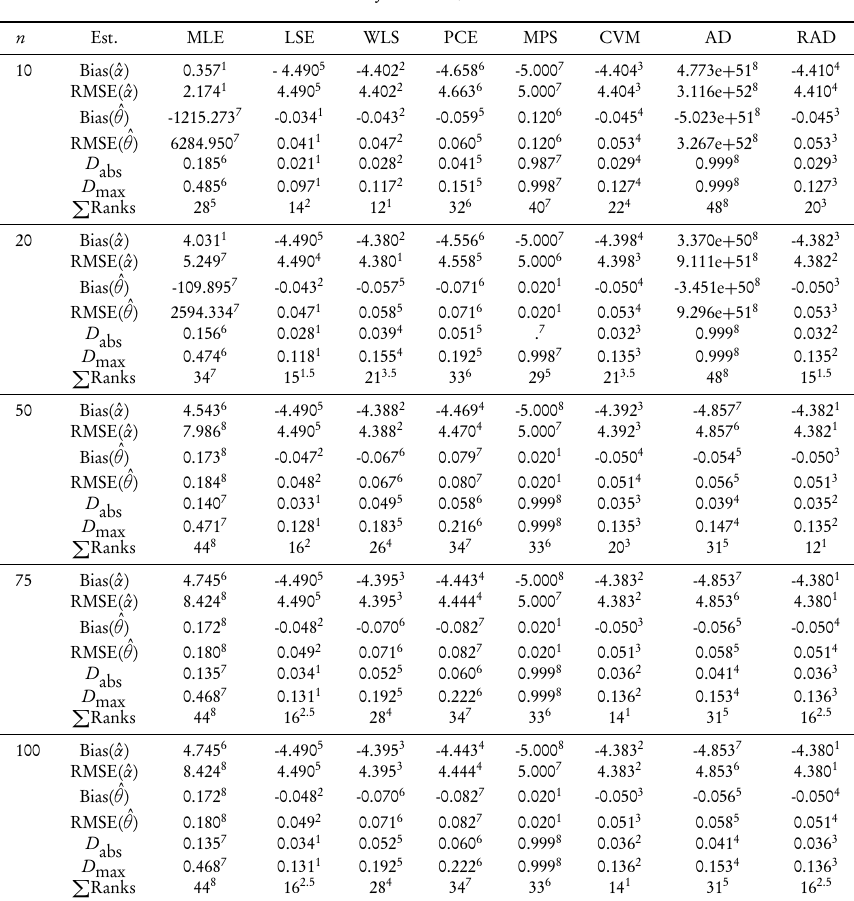
Simulation results for α = 5 , θ = 0.1 and λ = 1